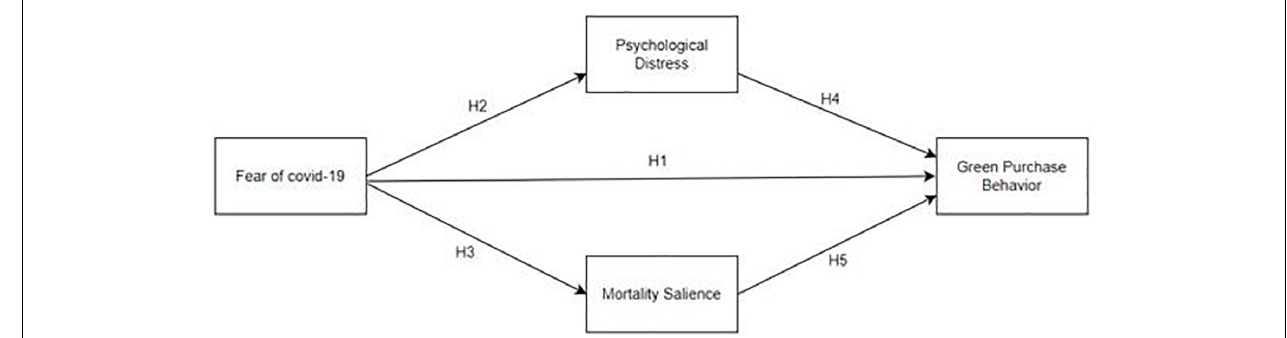
FIGURE 1 | Conceptual model.